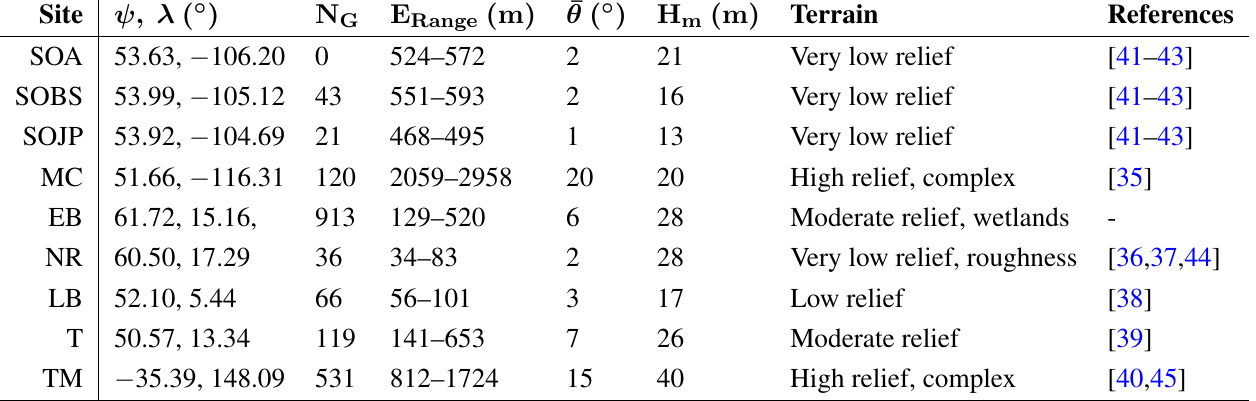
Table 3. Summary of site locations and terrain characteristics. ψ , λ are latitude and longitude, respectively. N is the number of usable (post filtering) GLAS footprints present G at each site. E is the study site elevation range (minimum to maximum). ¯ θ is site Range mean slope, and H is the site maximum vegetation height. These measures are sourced m from airborne LiDAR data. See the text for site code reference. MC, Mosquito Creek; T, Tharandt; LB, Loobos; NR, Norunda; TM, Tumbarumba.